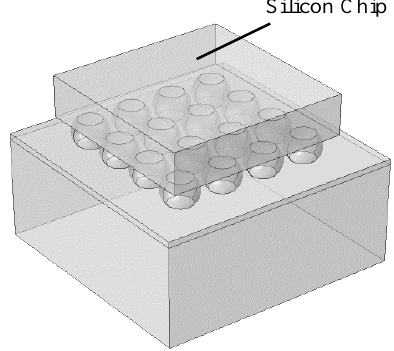
Figure 1. Geometry model of a flip chip component.